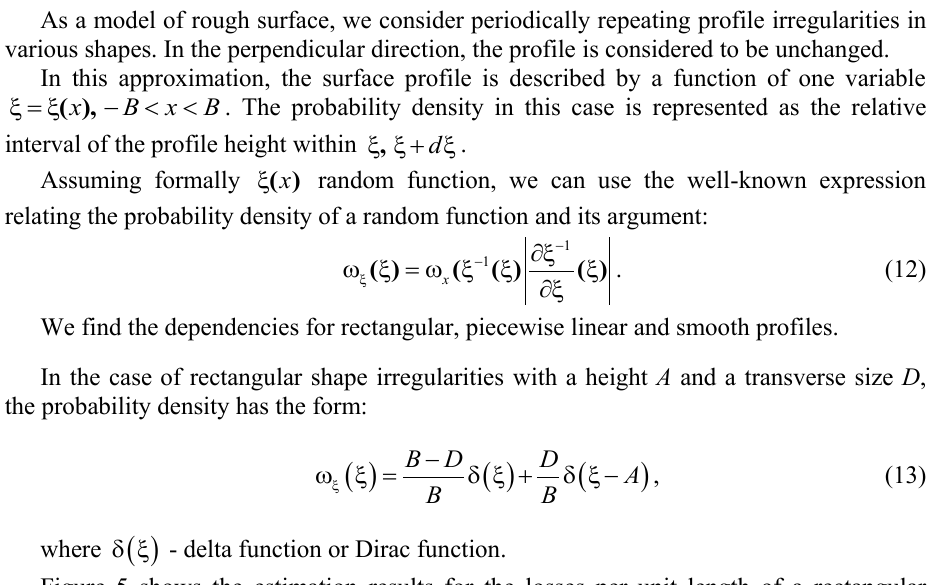
Fig. 4. Dependence on the frequency of the attenuation coefficient in the rectangular waveguide with the cross section of 1.1 / 0.55 mm for copper walls with different roughness size.